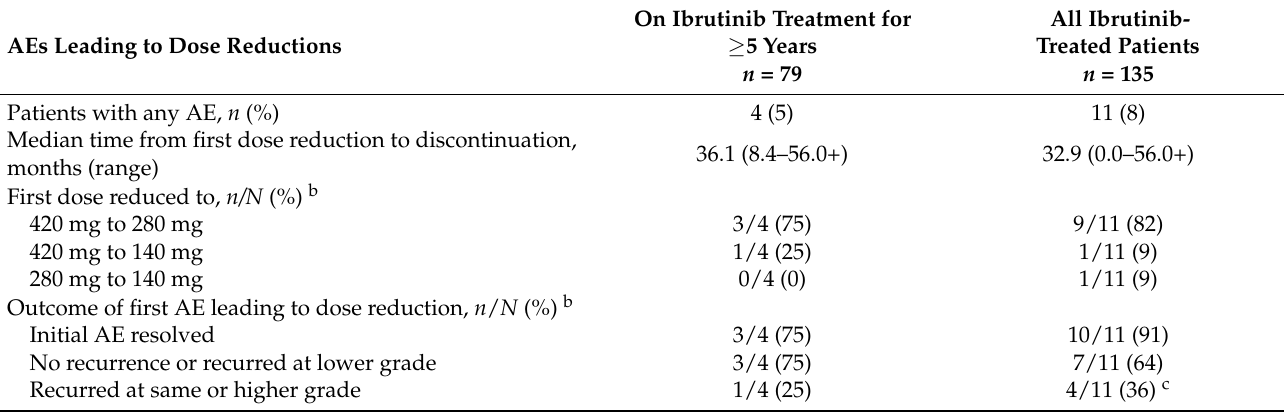
Table 3. AEs leading to dose reductions per USPI recommendations a